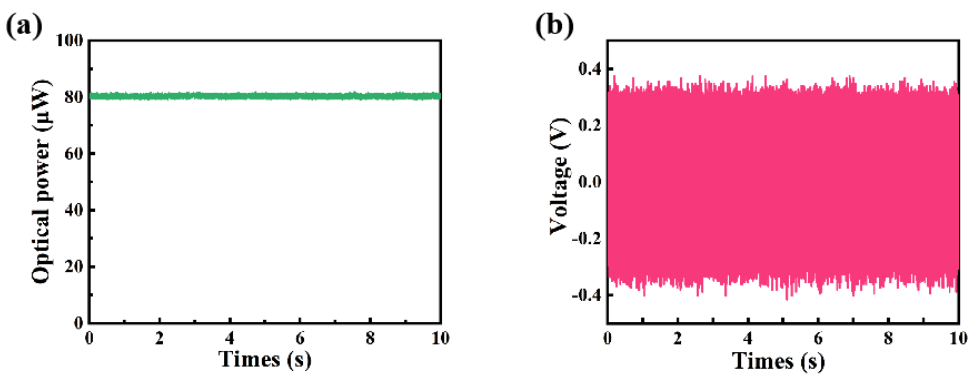
Figure 8. The experimental data of the UWOC link with total reflection angle of 7 ◦ : ( a ) optical power curve, ( b ) waveform